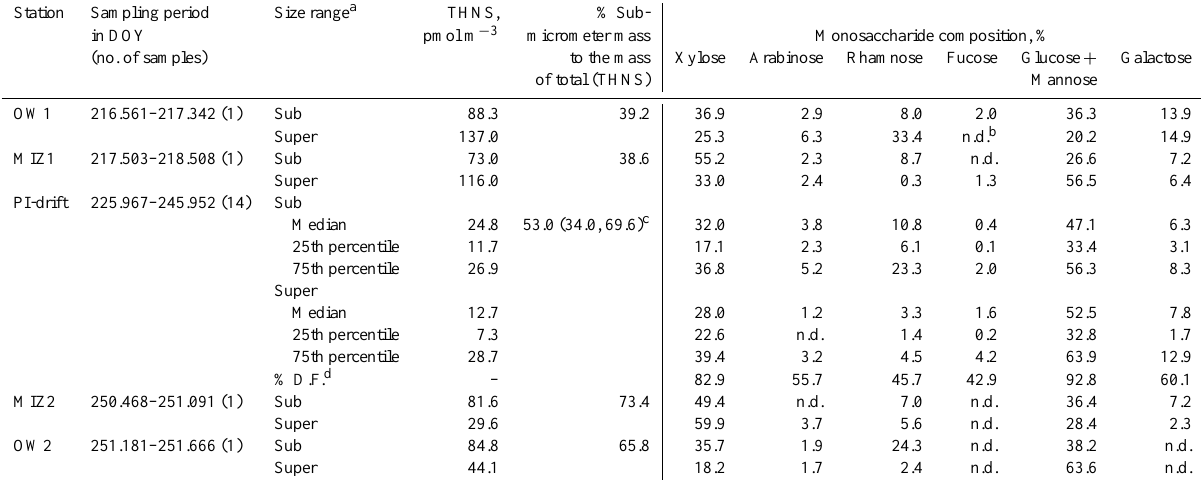
Table 2. Monosaccharide composition of size-resolved aerosol particles collected during ASCOS. Station Sampling period